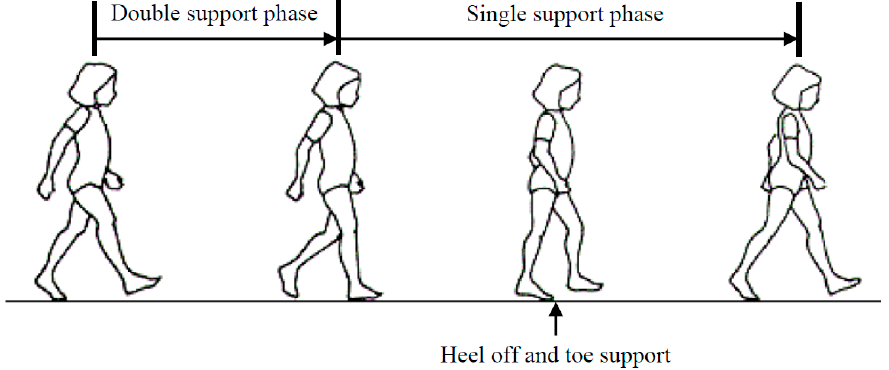
Figure 1. A single gait cycle of the human walking pattern. In the single support phase, the heel of the stance foot lifts off the ground and rotates around the toe, which is named “heel off and toe support”.